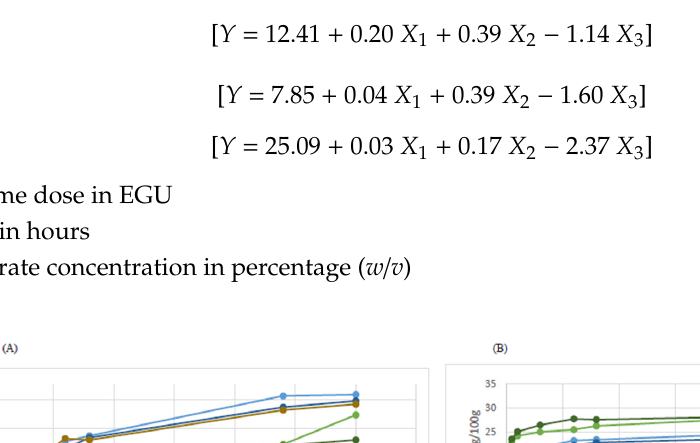
Figure 1. HPLC-RID analysis of ( A ) polysaccharides, ( B ) oligosaccharides ( C ) and simple sugars released from apple by-product during enzymatic treatment with Celluclast ® at atmospheric pressure.